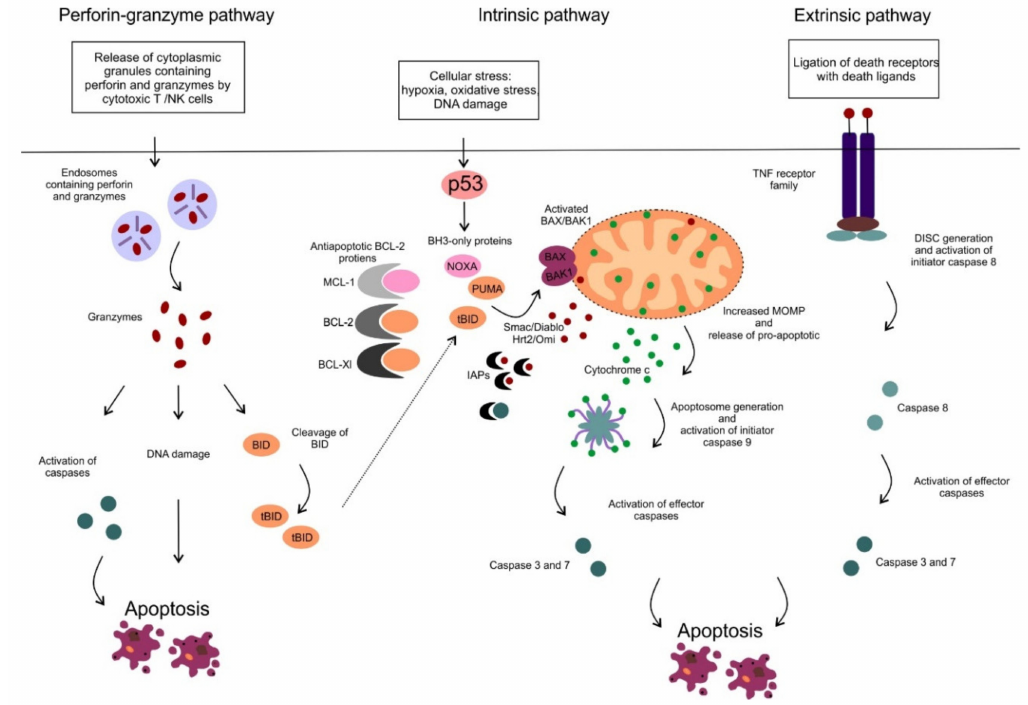
Figure 1. The perforin-granzyme, intrinsic (mitochondrial) and extrinsic apoptotic pathway. The extrinsic pathway is triggered via ligation of cell surface death receptors from the tumor necrosis factor (TNF) receptor family with death ligands (e.g., FAS ligand or TNF α ) on the outside of the cell membrane. Subsequently, a multiprotein complex: death-inducing signaling complex (DISC) is created on the cytosolic side of the cell membrane resulting in activation of pro-caspase 8. The initiator caspase 8 subsequently activates the e ff ector caspases (caspase-3 and 7), that cleave cellular proteins and promotes the apoptotic machinery. The perforin-granzyme and intrinsic apoptotic pathways are described in the